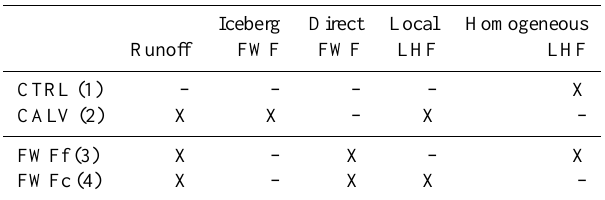
Table 1. Summary of treatment of freshwater fluxes coming from the ice sheet and of latent heat fluxes related to iceberg melting. Runoff: basal and surface melting of the ice sheet; iceberg FWF: melt flux related to iceberg calving; direct FWF: input of calving mass as freshwater flux into the first ocean cell next to the ice-sheet margin instead of forming icebergs; local LHF: take-up of latent heat at the position where the freshwater related to iceberg melt- ing is put into the ocean; homogeneous LHF: parameterisation of freshwater fluxes related to iceberg calving as take-up of latent heat homogenously around